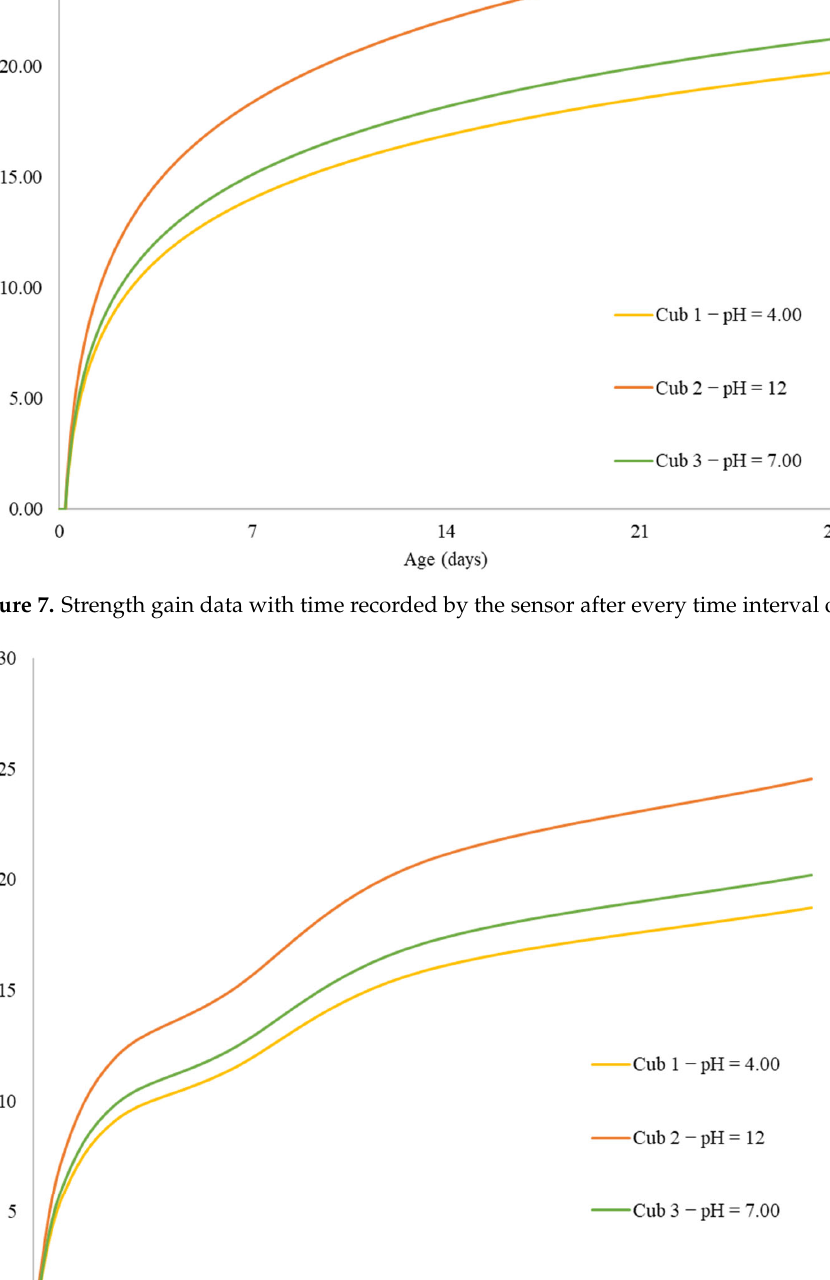
Figure 8. Strength gain data with time retrieved from the Sclerometer each